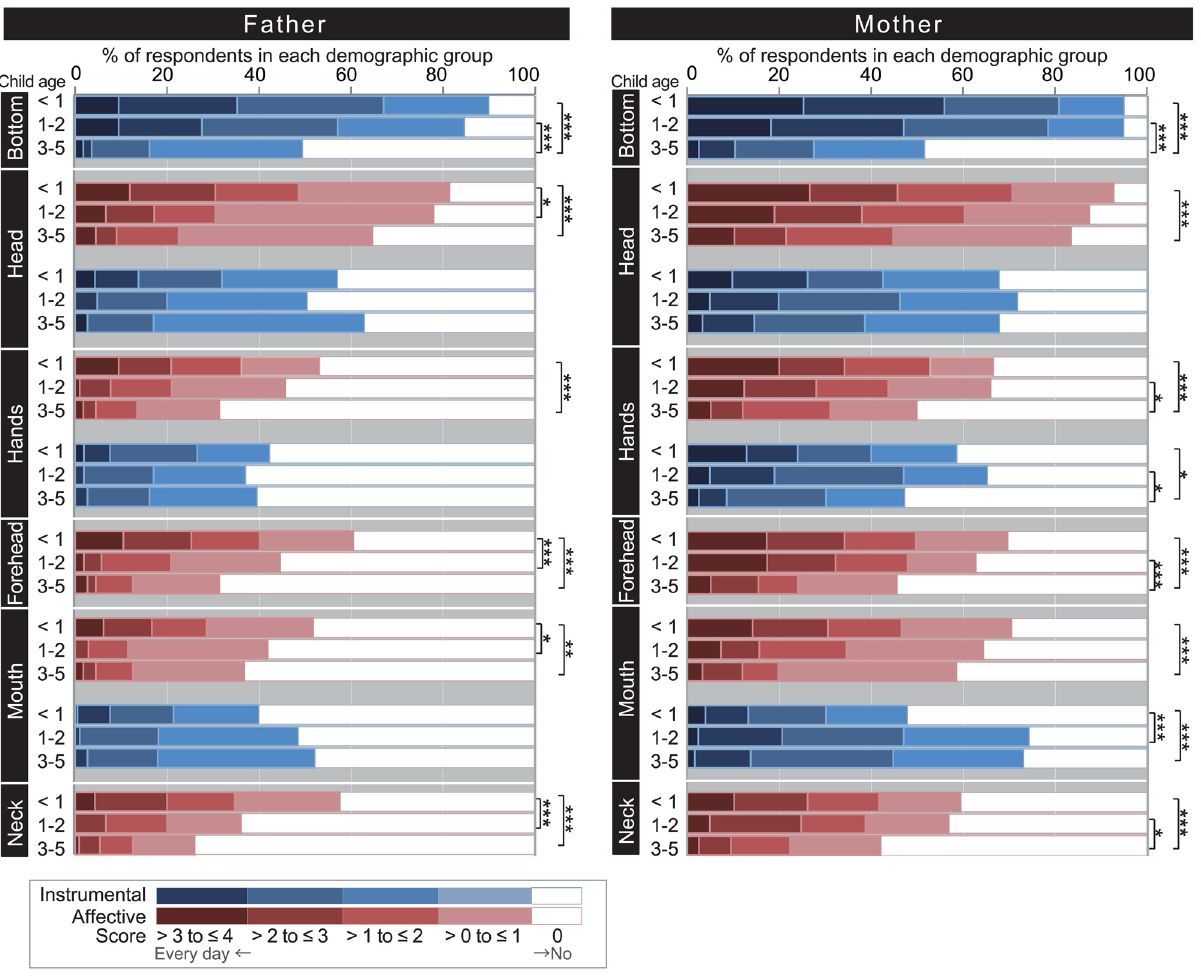
Fig 3. Cumulative bar chart showing differences in scores for the Child Odor in Parenting (COPs) subscales across child age groups. Scores on the COPs subscales are summarized for six demographic groups (i.e., parents ’ sex and child age groups; total n = 888). Scores for subscales comprised of the Instrumental factor are shown in blue, and for the Affective factor in pink. Scores for subscales were calculated by averaging 5-point rating scores across items (0, no expreience; 4, everyday, see Table 1 for detail). The Kruskal – Wallis test followed by a pair-wise Mann-Whitney test with Bonferroni correction was used to examine differences among child-age groups within each sex (father/mother). * p < .05. ** p < .01. *** p < .001. Comparisons between sex and body parts are shown in S1 and S2